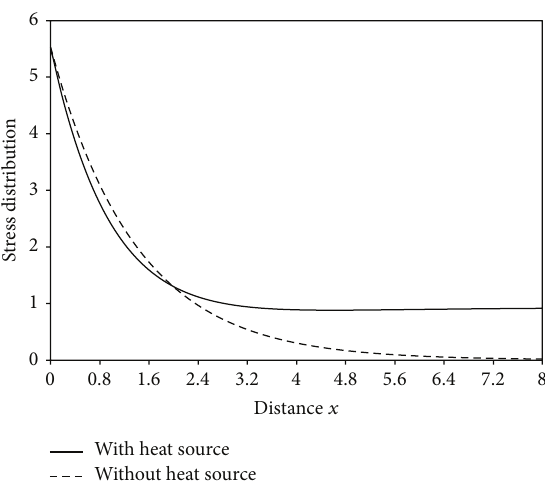
Figure 12: Effects of viscosity and two-temperature parameter on conductive temperature.